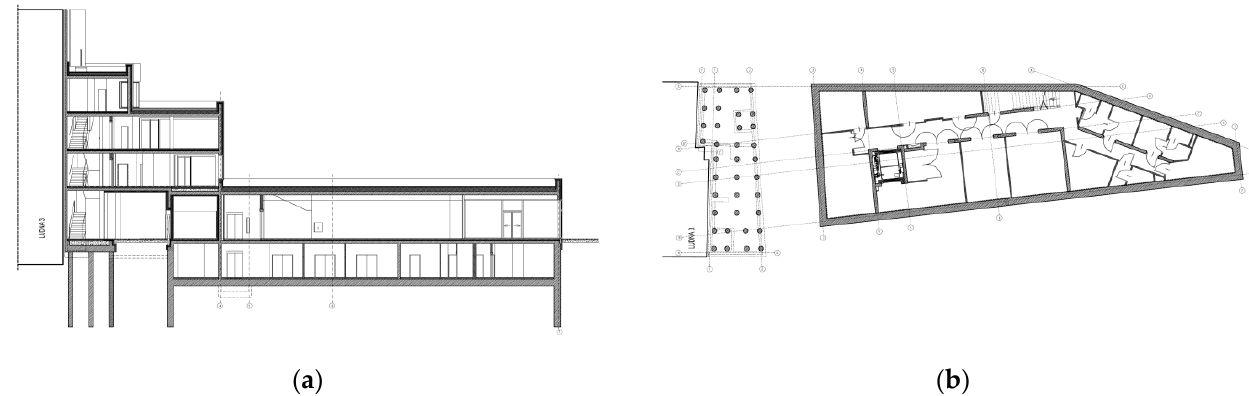
Figure 2. Longitudinal section of building D ( a ) and level − 1 ( b ) projection (own drawing based on—Kuryłowicz, S., Kuryłowicz, E., Gientka, T., Krze´sniak, M., Miklaszewska, K., Pianko, M., T˛eskny, M., Kuczy´nski, P. Architectural and con- struction design of residential buildings with an underground garage and commercial premises Solec/Ludna/Wilanowska Streets. Warszawa